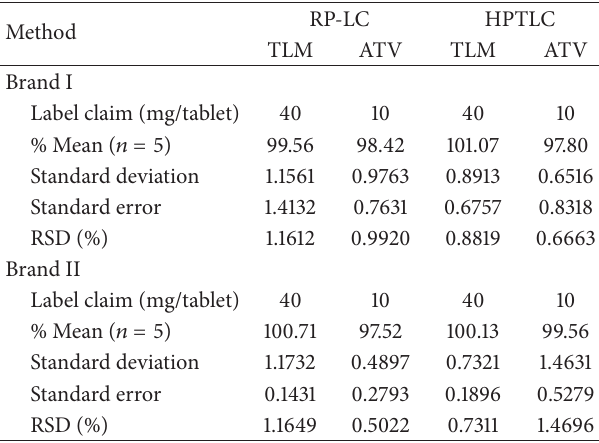
Table 4: Results of analysis of tablets.